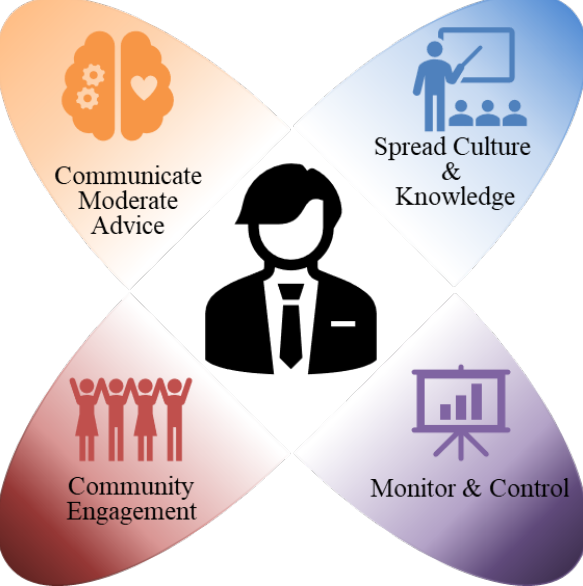
Figure 8. Tasks of the community